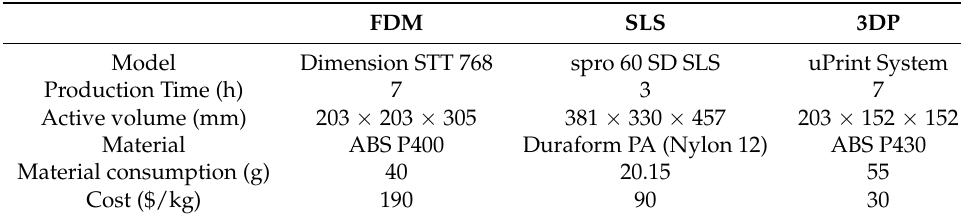
Table 2. Characteristics of the most used machines for